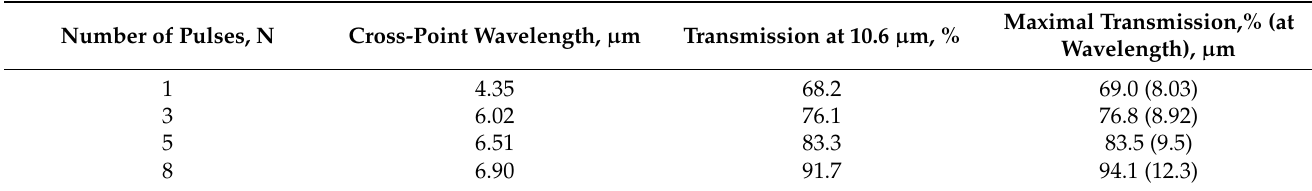
Table 1. Cross-point wavelengths and transmission of the ARM inscribed at E = 37.5 nJ on the both sides of the GaSe sample. Number of Pulses, N